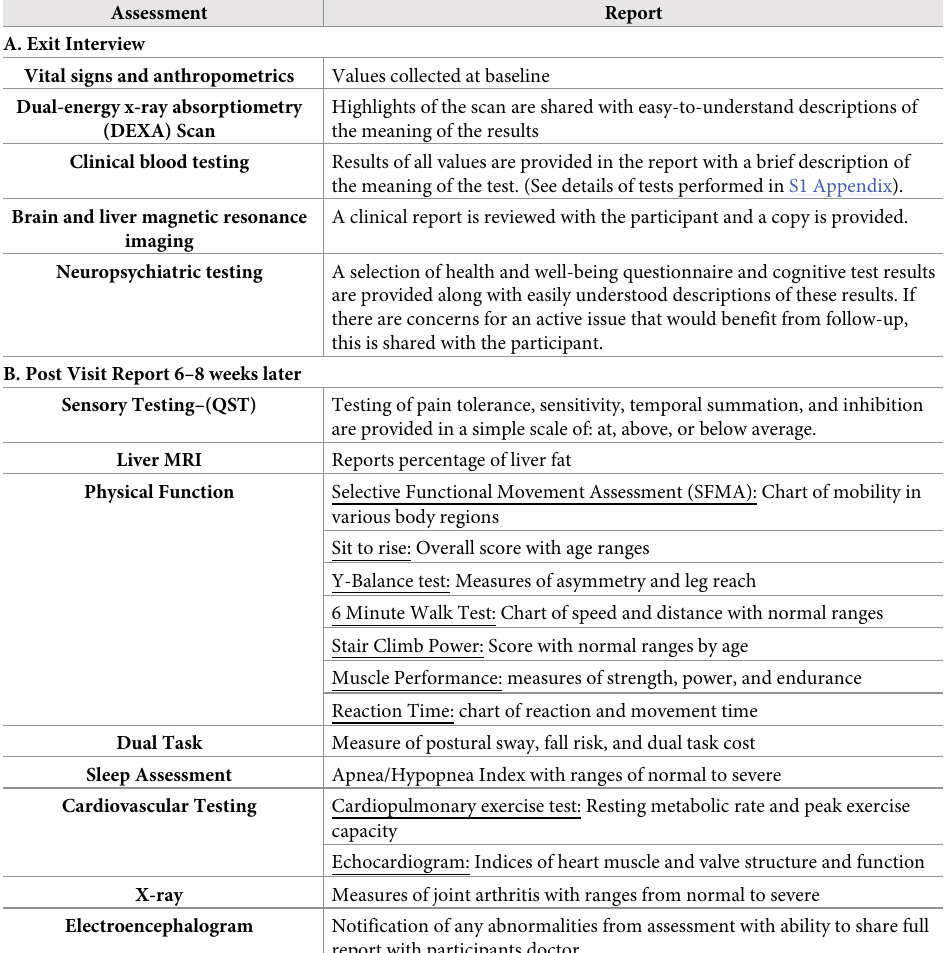
Table 3. Clinical results returned to participants in the Football Players Health Study’s In-Person Assessment during the Exit Interview (A) and in the Post Visit Report �